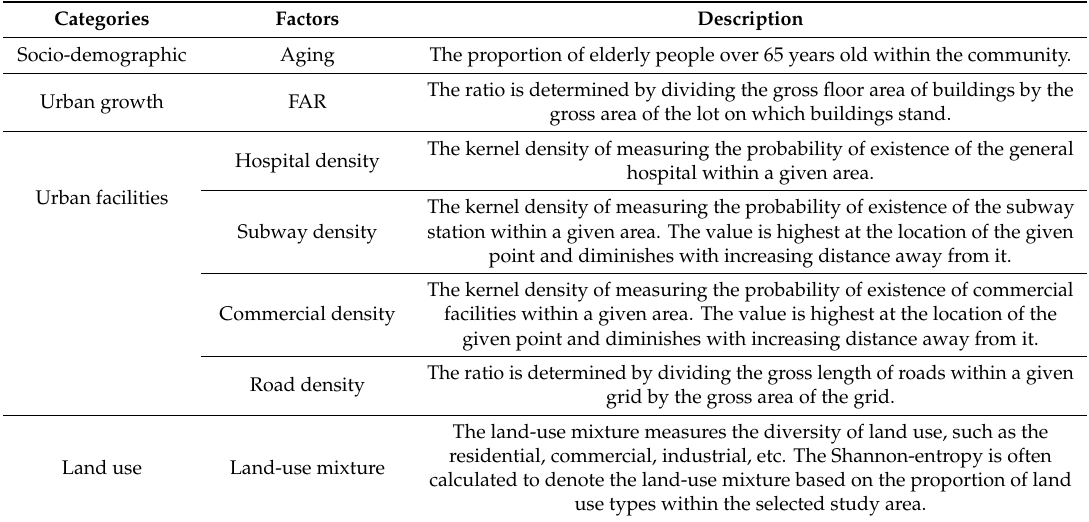
Table 2. Summary of urban